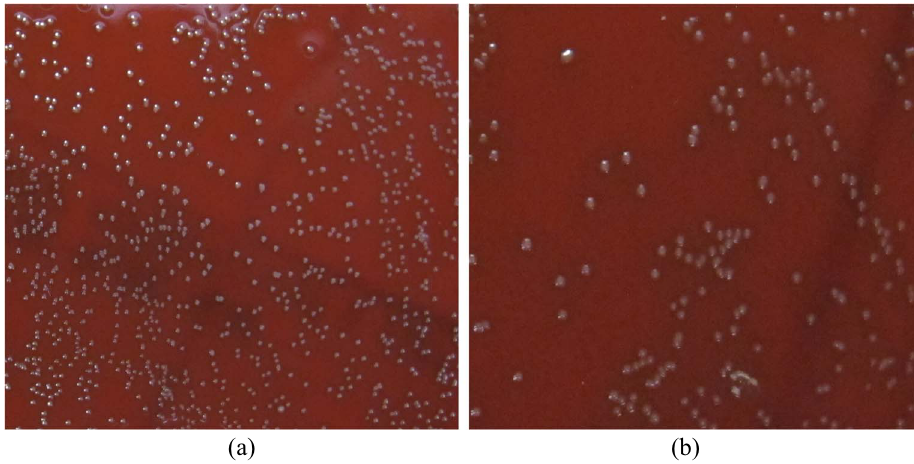
Figure 1. Streptococcus gordonii ; Culture plates (a) Control. (b) 120 s.